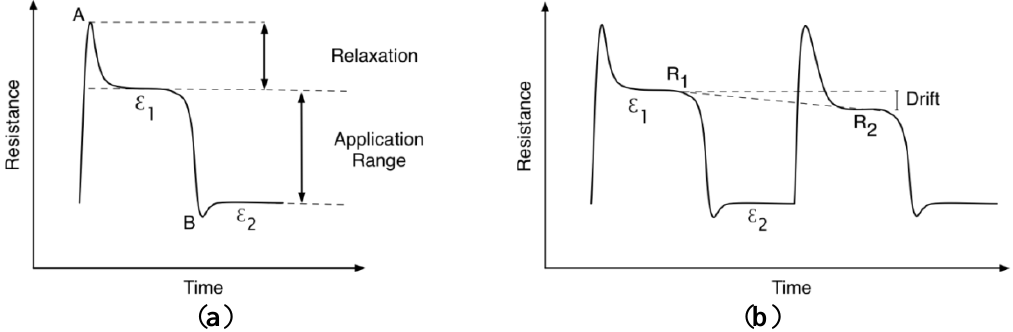
Figure 6. Definition of signal relaxation ( a ) and drift ( b ) behavior for cyclic tensile measurements.